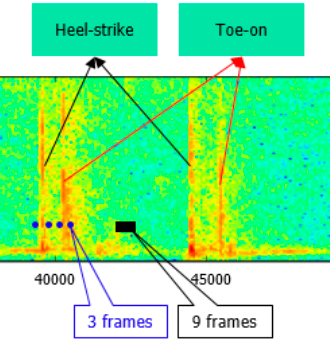
Figure 4. Spectrogram of footstep and training sample selection (blue ones are positive samples, in total 3 × 4 = 12 frames for each step; black ones are negative samples, in total nine frames for each step). Footstep